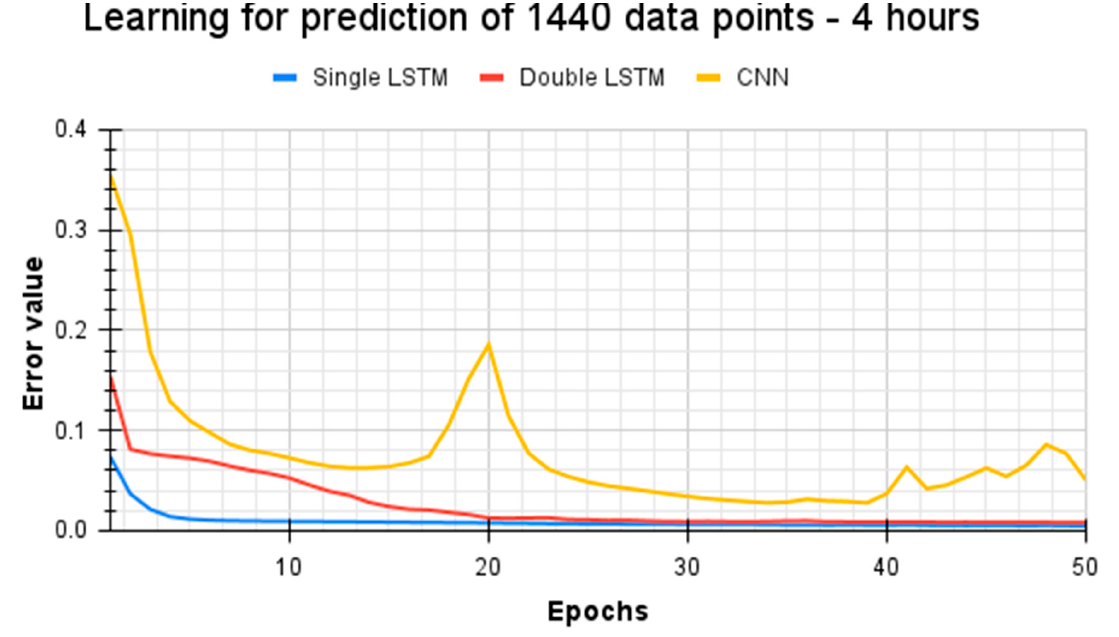
Figure 9. Comparison of the learning process of different types of LSTM and CNN networks in the 4 h forecasting horizon: X -axis—next epochs, Y -axis—error level. 4 h forecasting horizon: X -axis—next epochs, Y -axis—error level.